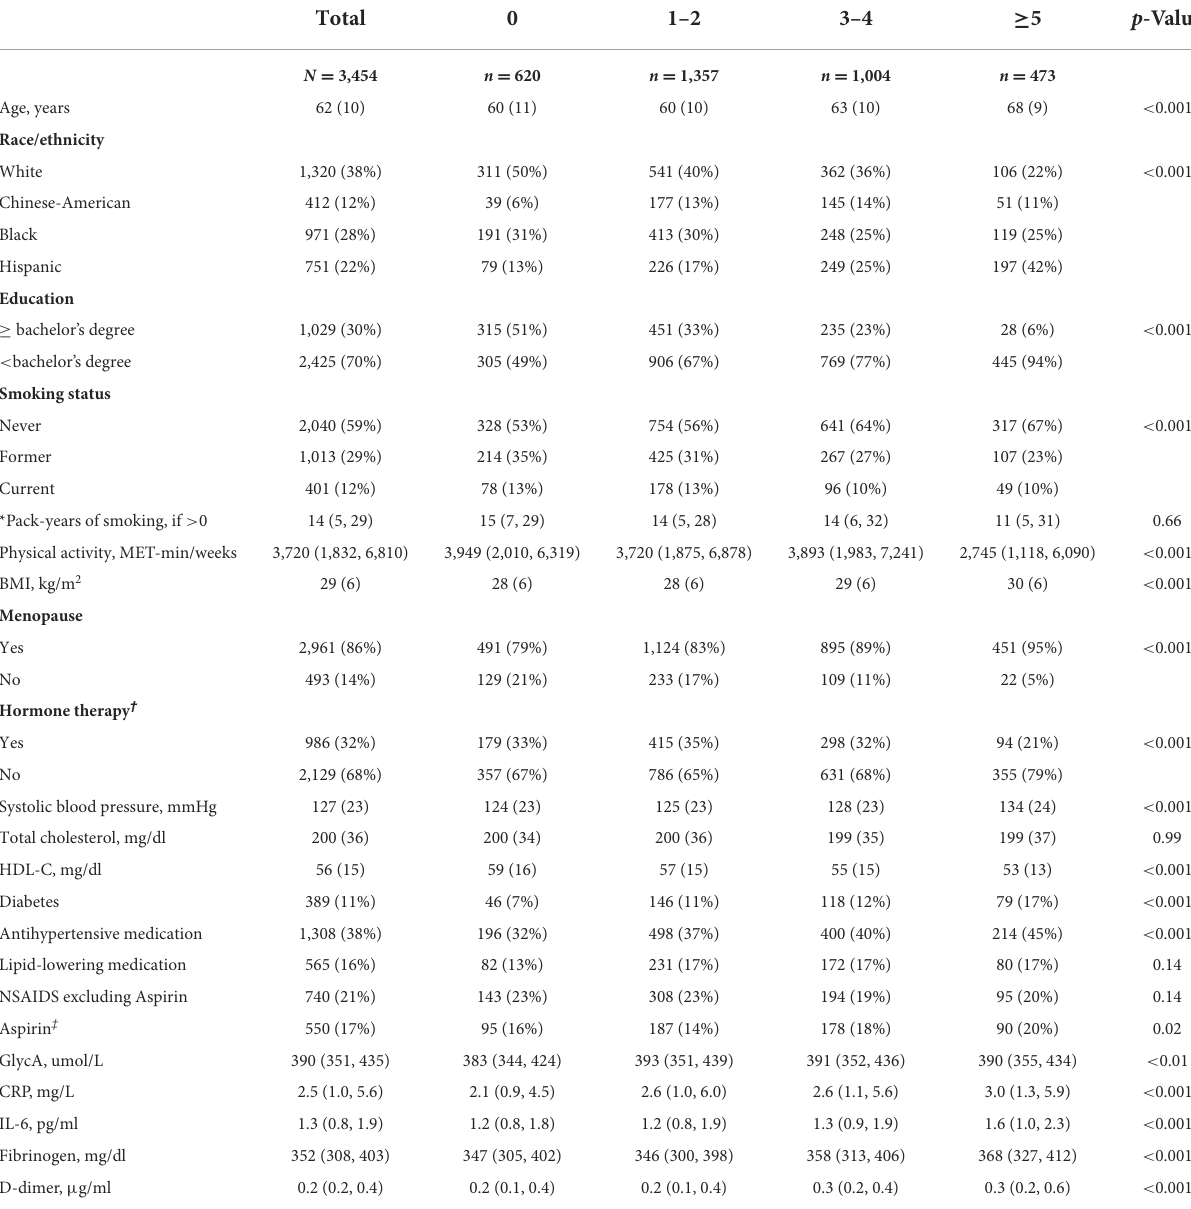
TABLE 1 Baseline characteristics of study participants by parity